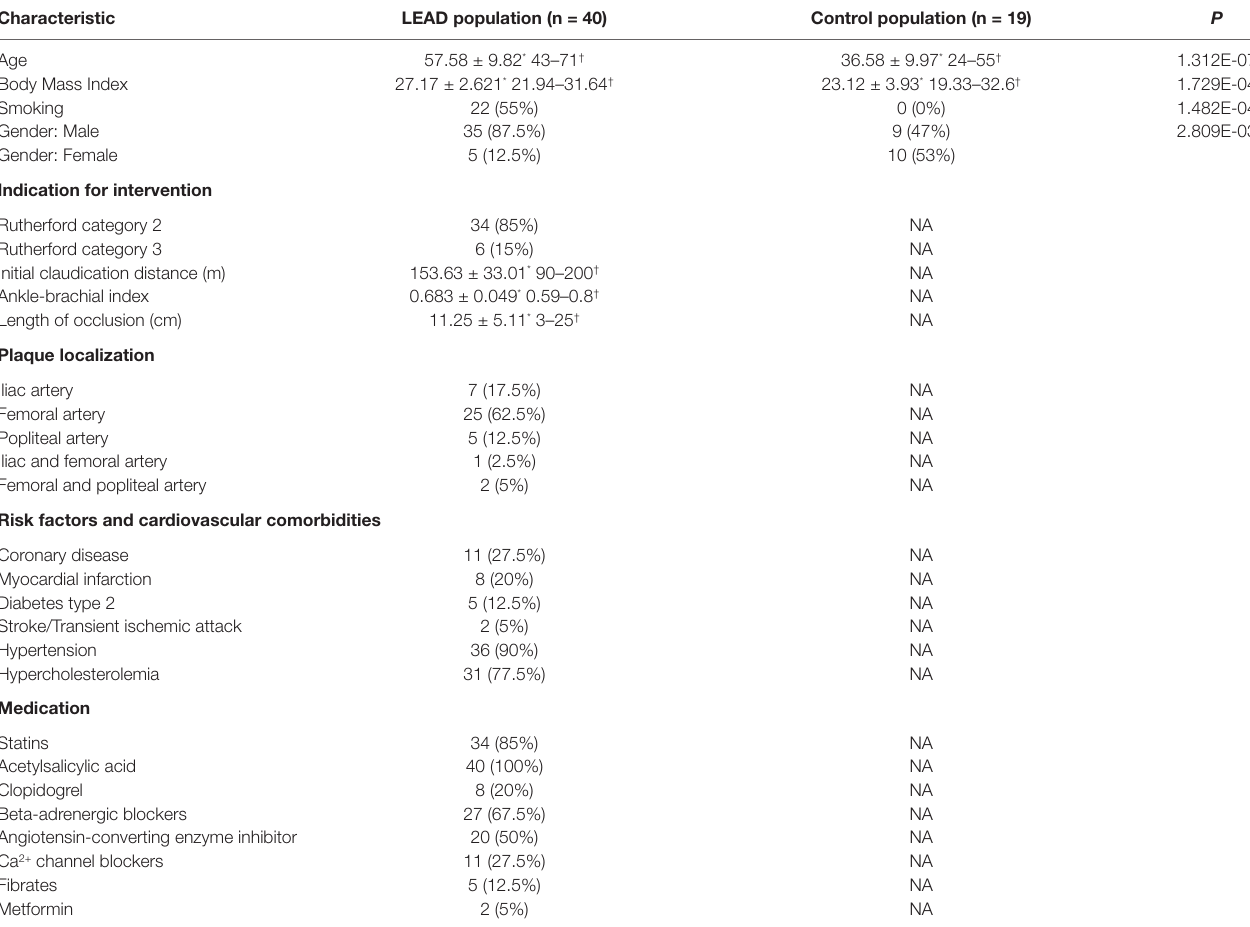
TABLE 1 | Characteristics of 40 patients with LEAD and 19 controls approved to the study.